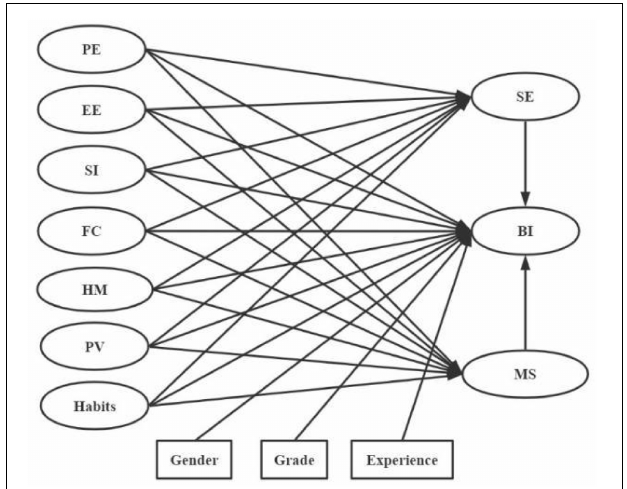
FIGURE 2 | UTAUT2-based e-learning